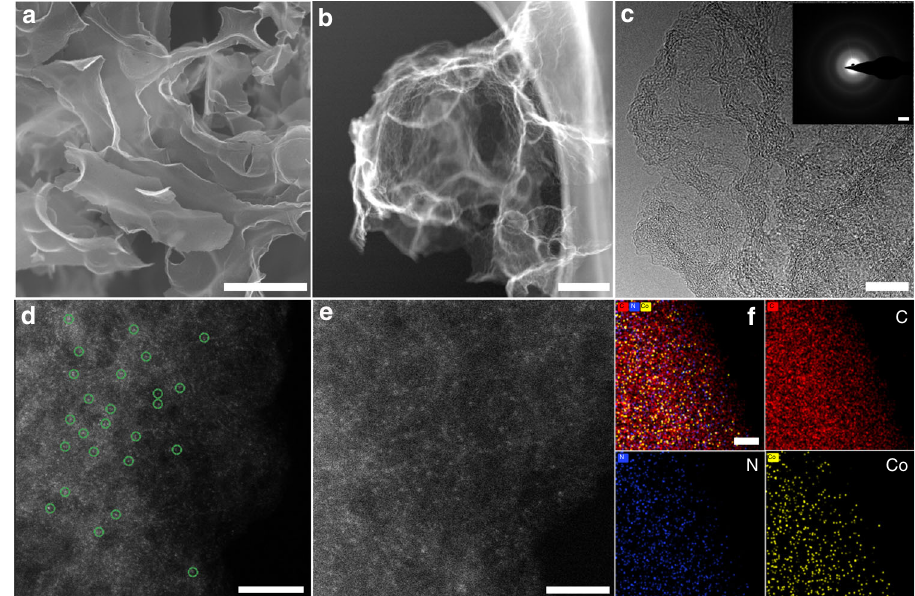
Fig. 1 Microstructure and morphology characterizations of Co-SA/N-C catalyst. a SEM image. Scale bar, 1 μ m. b HAADF-STEM image. Scale bar, 200 nm. c HRTEM image. Scale bar, 10 nm. SAED pattern (inset). Scale bar, 2 1/nm. d , e Zoom-in HAADF-STEM image. Scale bar, 5 and 2 nm, respectively. f Elemental mapping images. Scale bar, 20